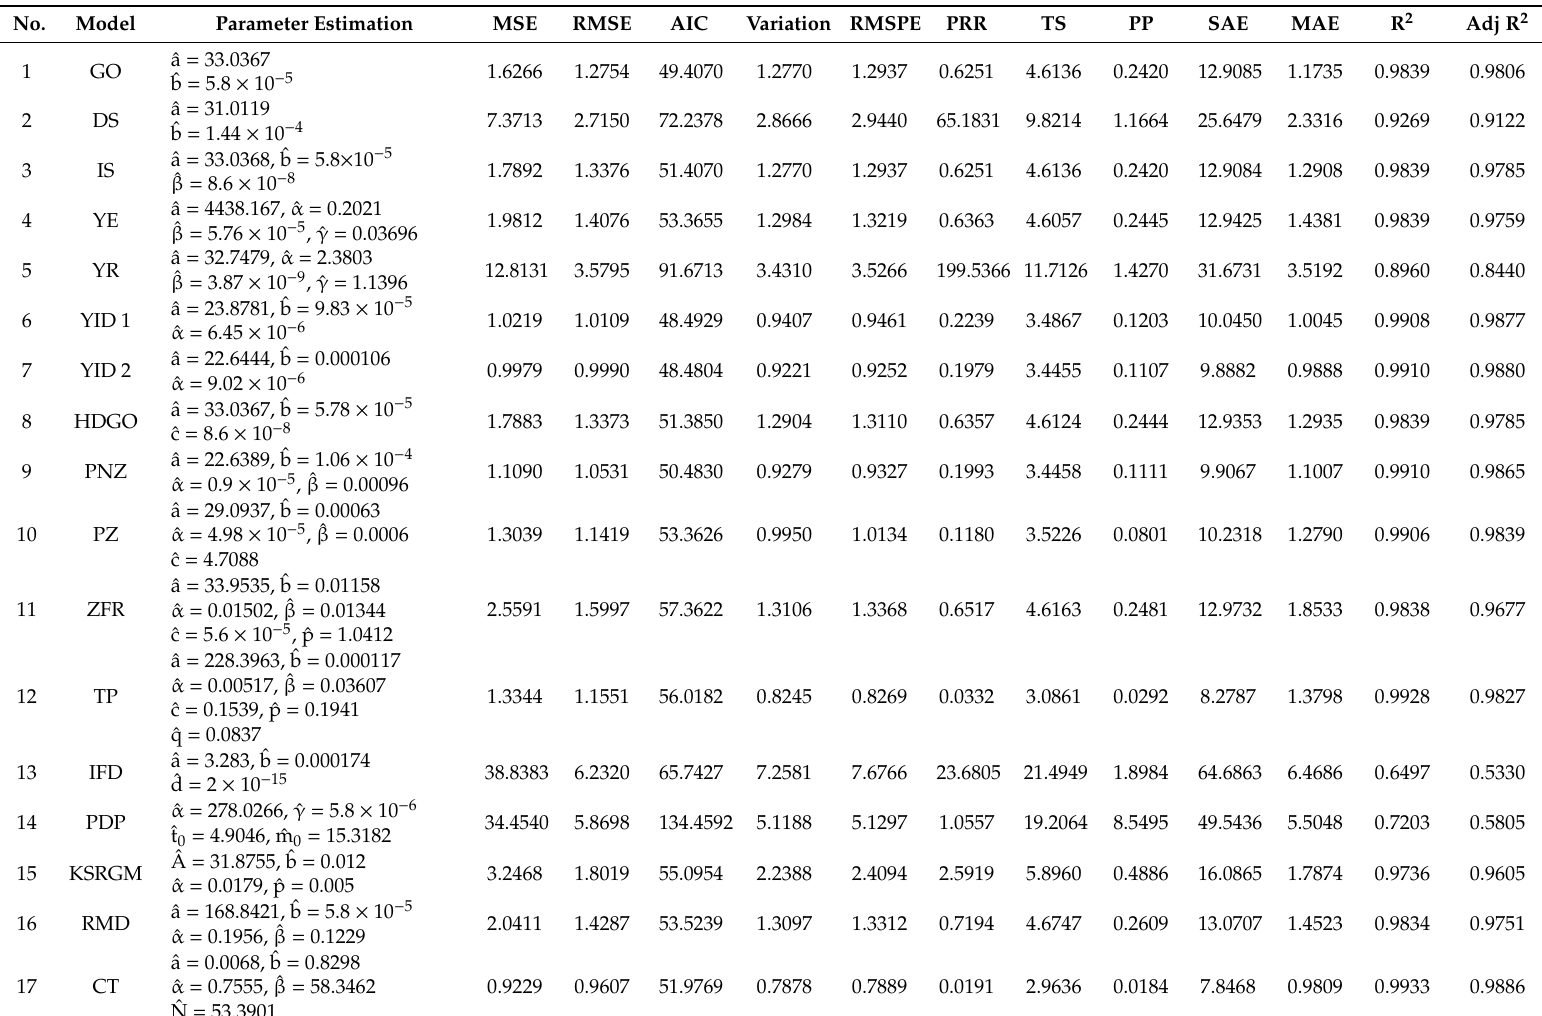
Table 7. Results of model parameter estimation and criteria from dataset